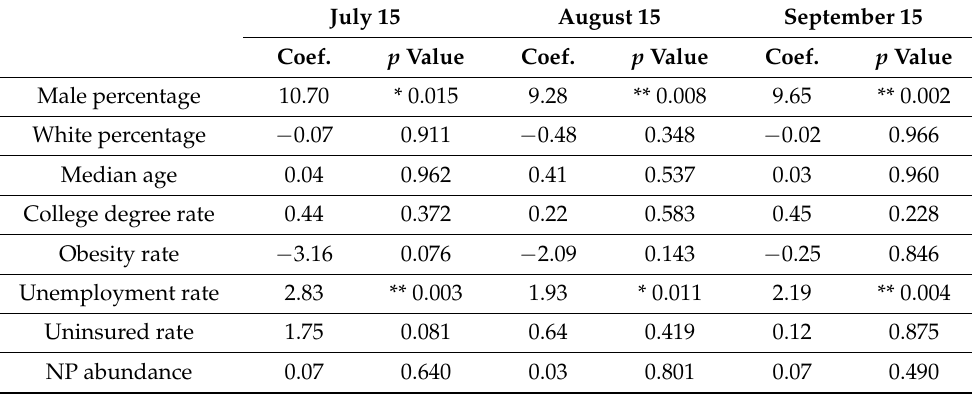
Table 3. Coefficients of the explanatory variables in